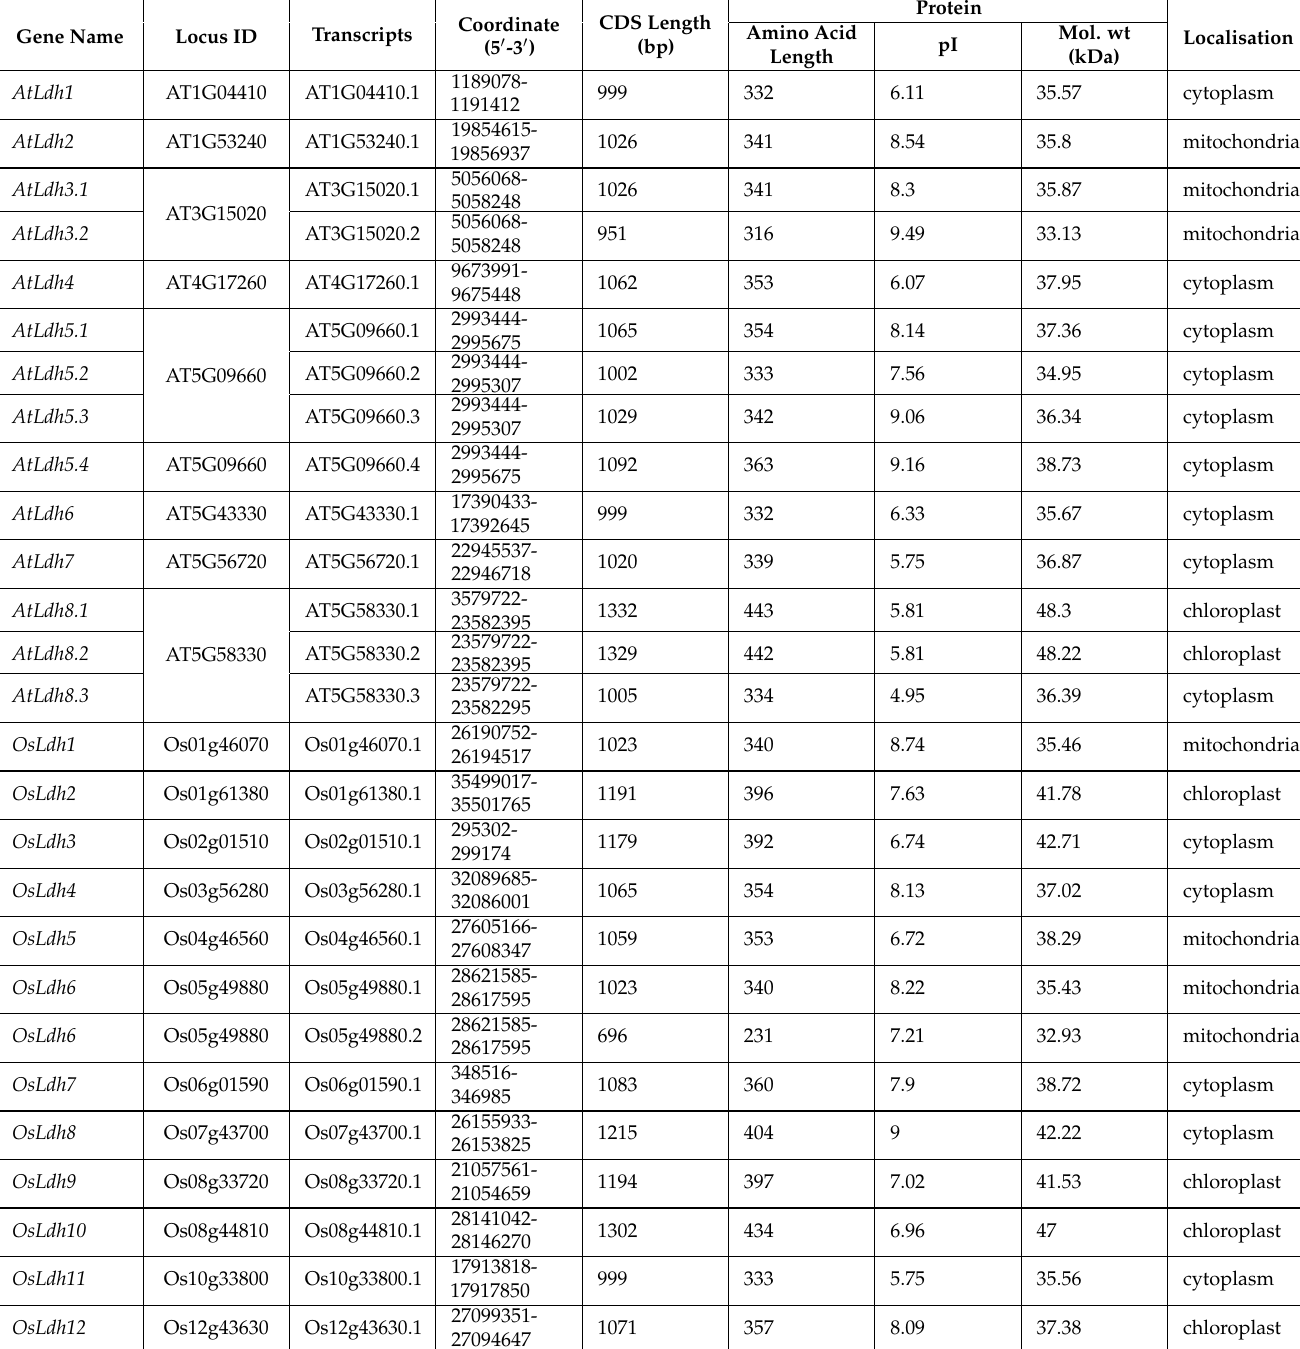
(blue) and LDH1_C (green) domains characteristic of Ldh proteins. Domains were analysed using SMART database. Position and number of domains are schematically represented along with the length of the protein and are not to scale. Table 1. Details of putative Ldh genes predicted in Arabidopsis and rice genome. Table enlists Ldh genes in rice and Arabidopsis , along with their existing locus identifiers, nomenclature, chromosomal locations, CDS, protein length and sub-cellular localization.